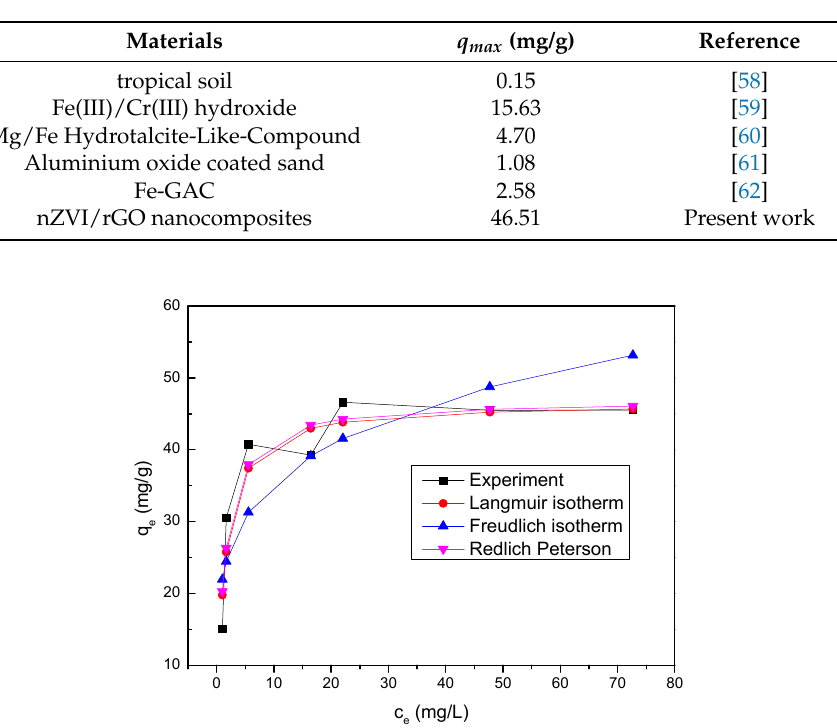
Table 6. Removal quantity of various adsorbents for Se(IV).